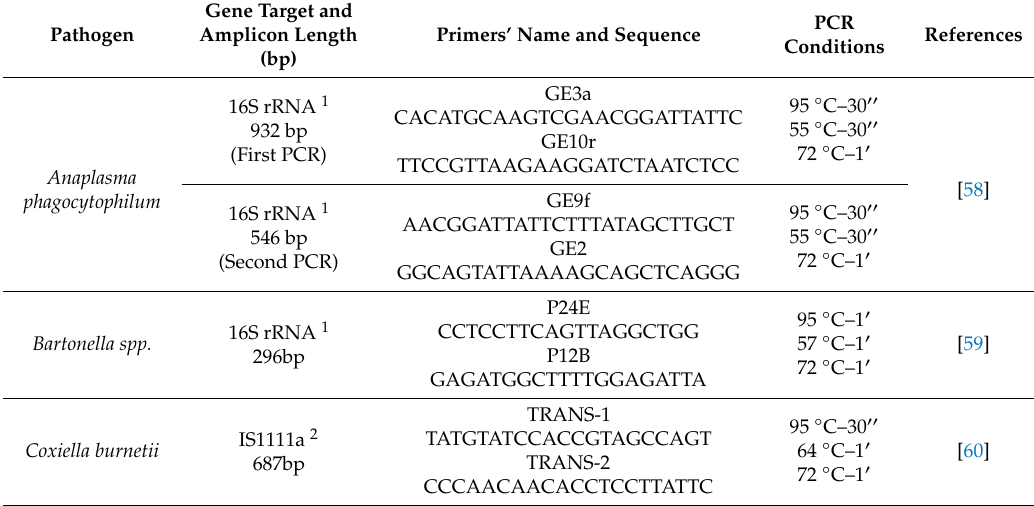
Table1. Genetarget, ampliconlength, primerpairs, andPCRconditionsusedforthedi ff erentpathogens.